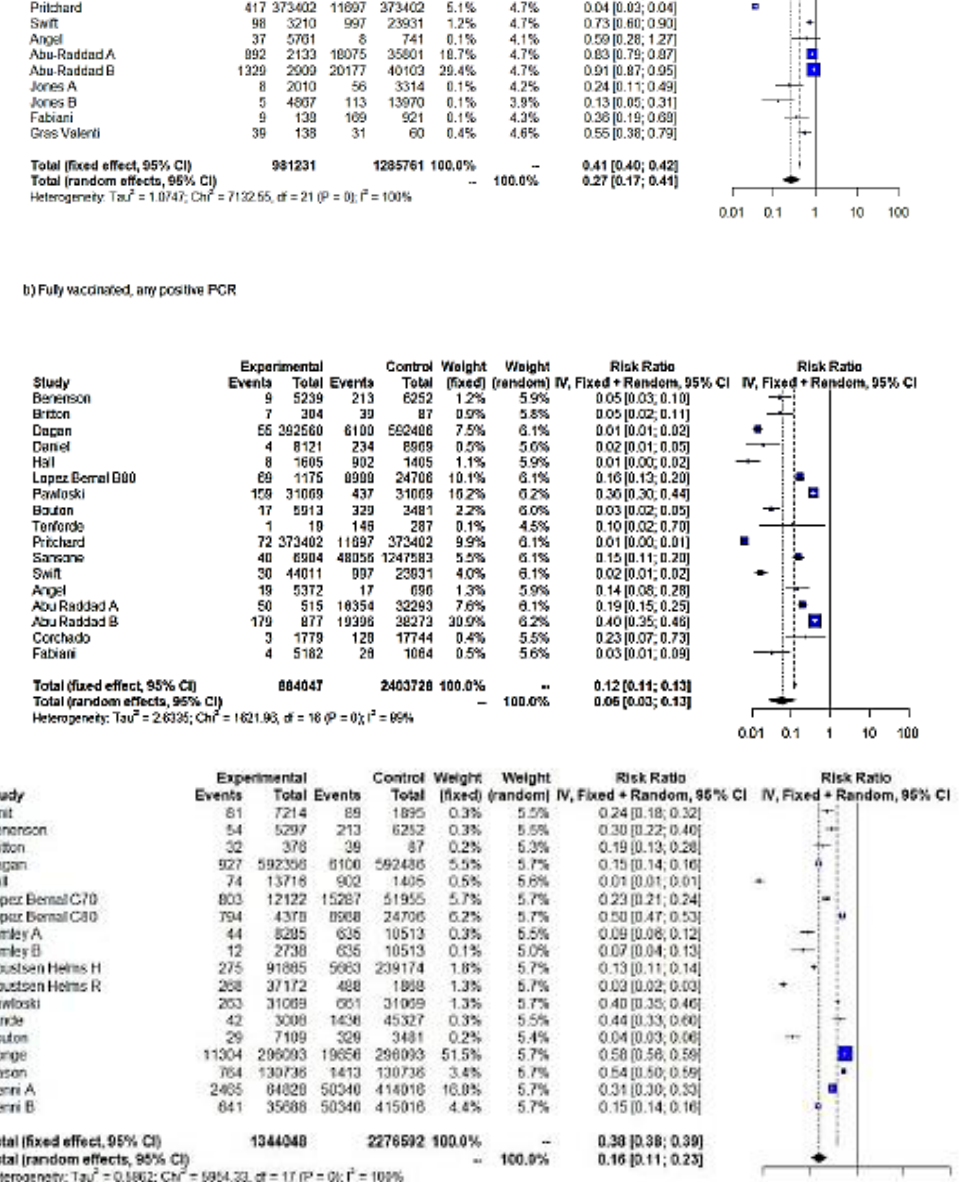
Figure 2. Forest plot, partially vaccinated. Any positive SARS-CoV-2 PCR RR (95%-CI) ≥ 14 days from first dose uptake ( a ). Forest plot, fully vaccinated. Any positive PCR RR (95%-CI) ≥ 7 days from full vaccination ( b ). Forest plot, any positive PCR RR (95%-CI), ≥ 14 days from vaccination with at least one dose. IV method ( c ).